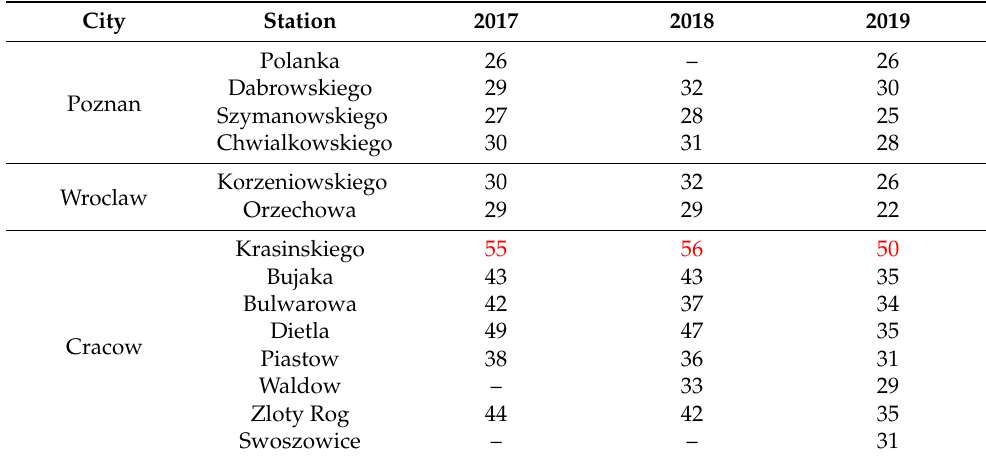
Table 4. Average annual concentration of PM10 in Polish cities (ug/m 3 ) [12,13,18,27,28,30–36].